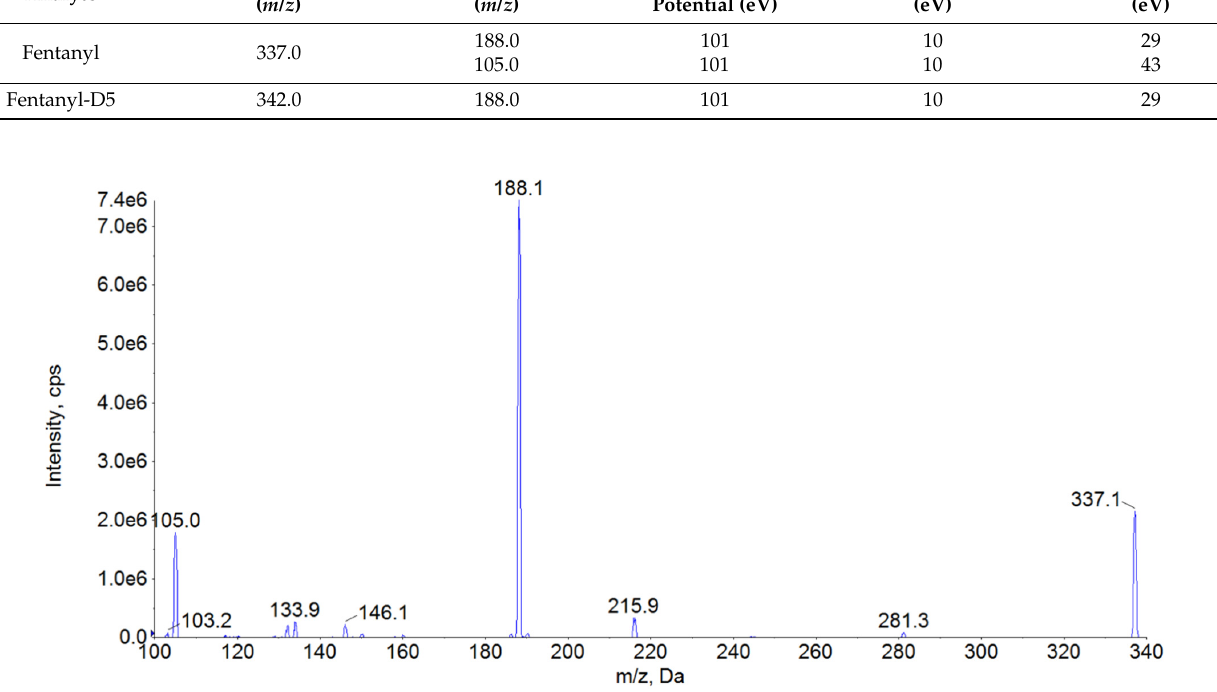
Figure 3. MS 2 spectra of FEN. The daughter ions with the highest intensity were found to be 105 m / z and 188 m / z